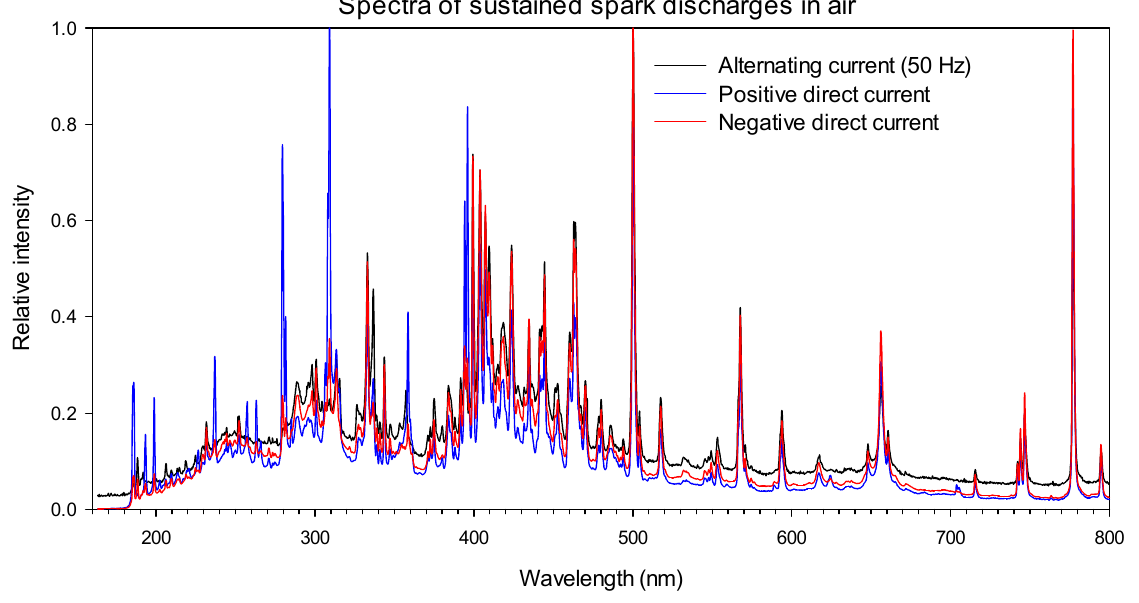
Figure 3. Sustained spark discharge spectra of a needle-plane gap in air.